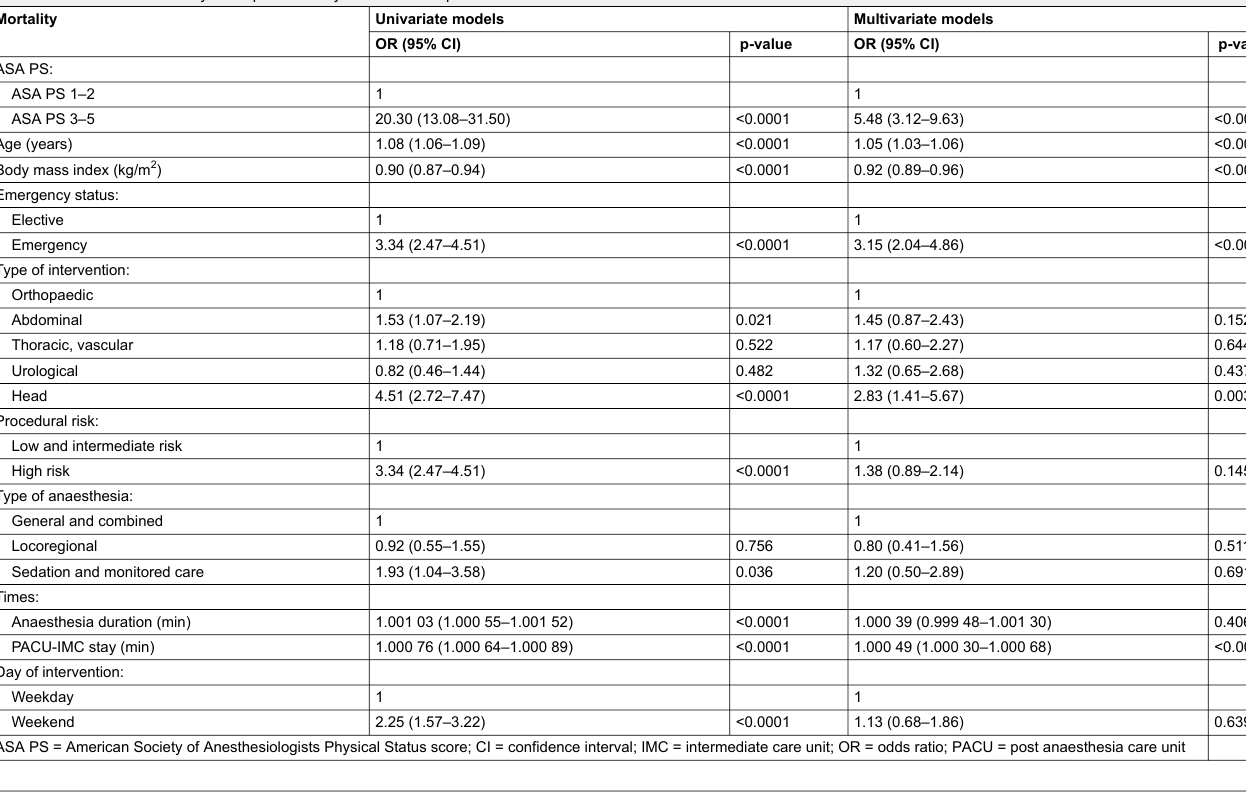
Table 3b: Risk factors of 30-day in-hospital mortality for patients with a PACU or an IMC